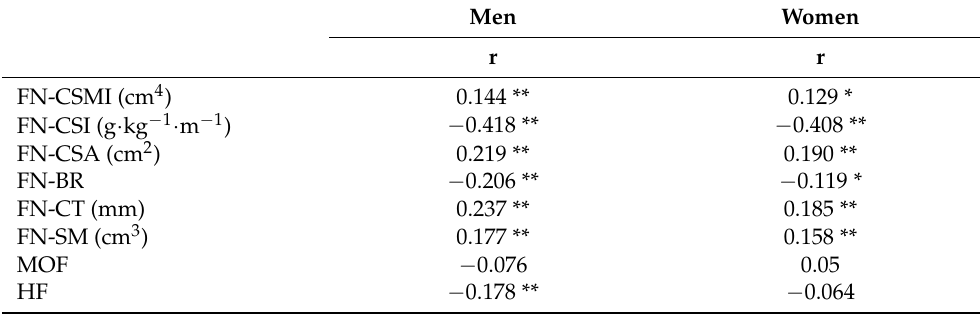
Table 2. Correlations of triglyceride glucose–body mass index and bone strength and risk of fracture. Men